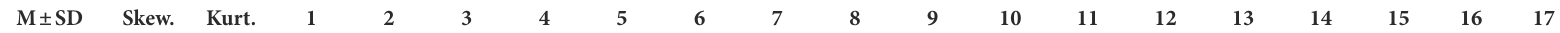
TABLE 1 Descriptive statistics for the measures of home numeracy and mathematics along with their correlations (controlling for the covariates). Variable M ± SD Skew.